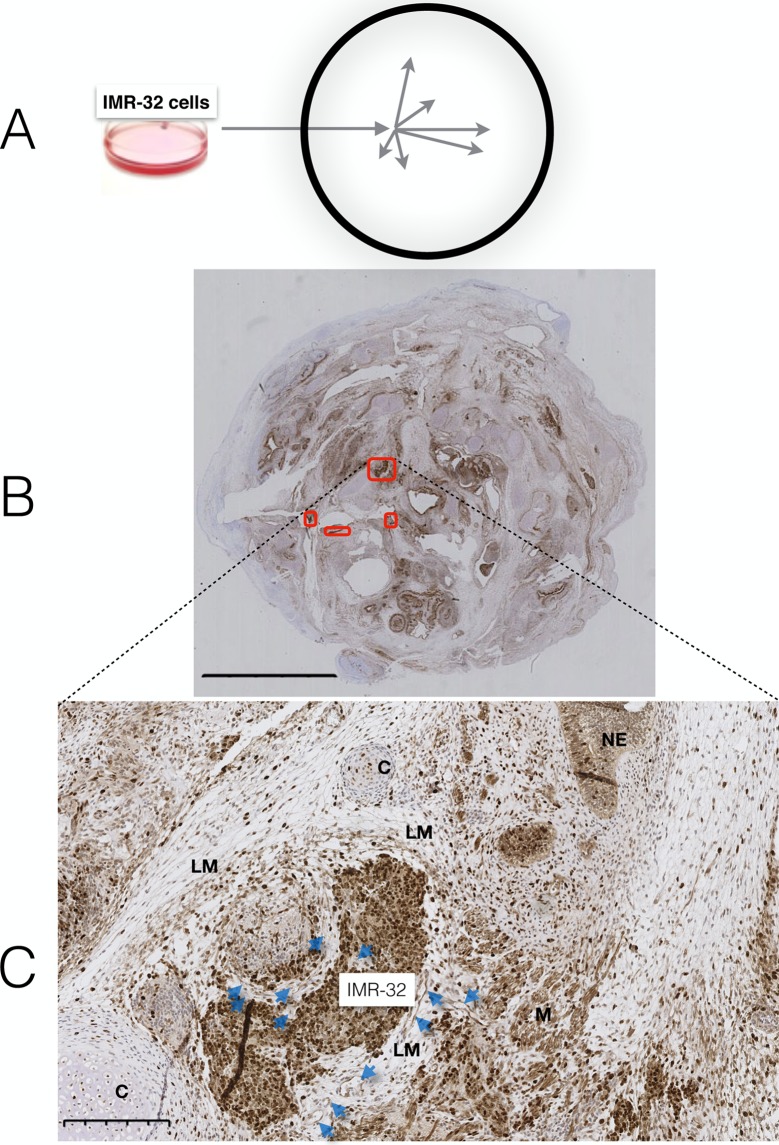
Micro colonisation of IMR-32 tumours in the PSCT model.(A) Schematic illustration; NB cells were injected into an arbitrary position centrally in the PSCT cellular mass, resulting in multiple micro-colonisations from migrating NB cells. (B) A representative FFPE section of a PSCT with four IMR-32 colonies indicated (red borders). (C) IMR-32 colony surrounded by loose mesenchyme. LM = loose mesenchyme; NE = neural epithelium; C = cartilage; M = muscle; Blue arrows = vessels. Size bars: B:5mm, C:500μm.